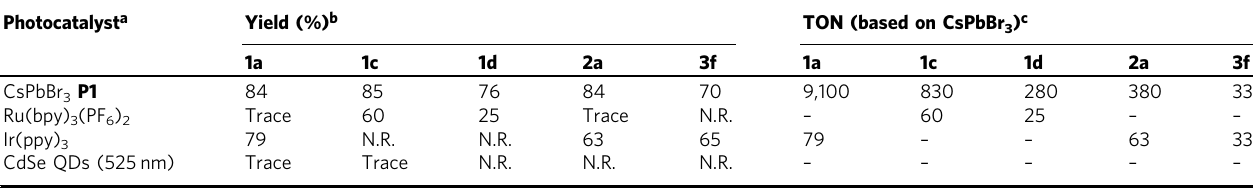
Table 1 Comparison of photocatalysts for corresponding reactions in air or in oxygen Photocatalyst